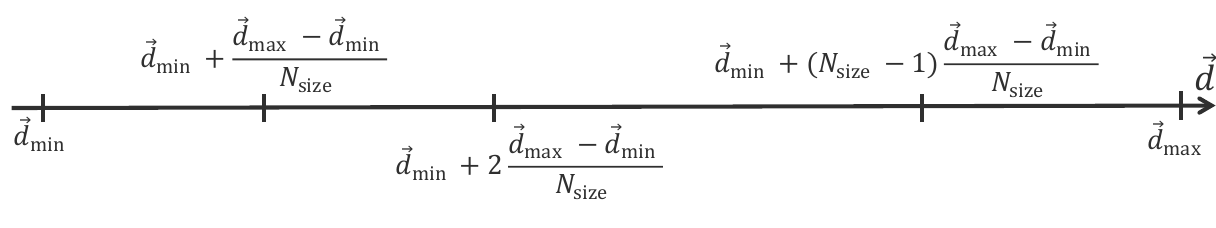
Figure 12: User-defined floe size interval with subdivision.